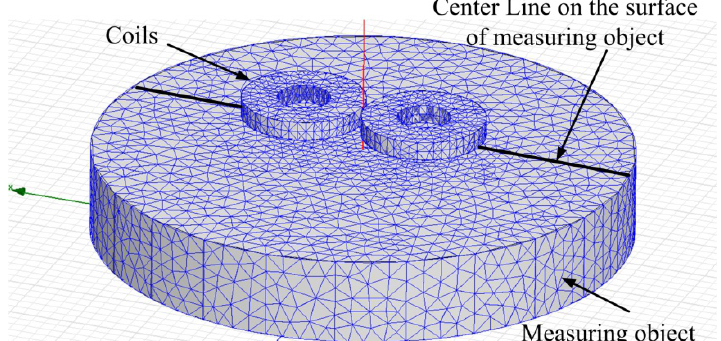
Figure 9. The simulation model and the mesh grids of the probe and measuring object used for FEM